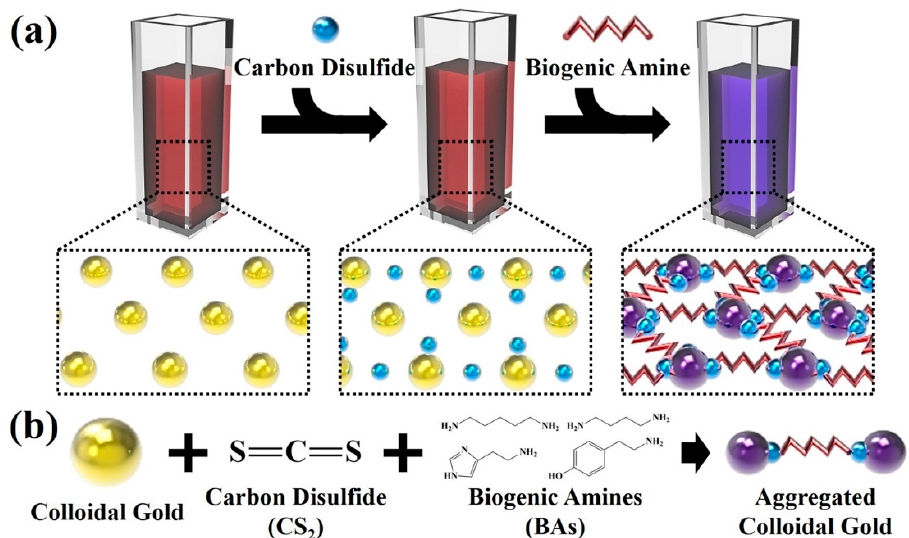
Figure 1. Schematic illustration of ( a ) the colorimetric detection of biogenic amines based on the simple mixing of carbon disulfide and gold nanoparticles and ( b ) aggregation of colloidal gold nanoparticles solution with the addition of carbon disulfide and biogenic amines.